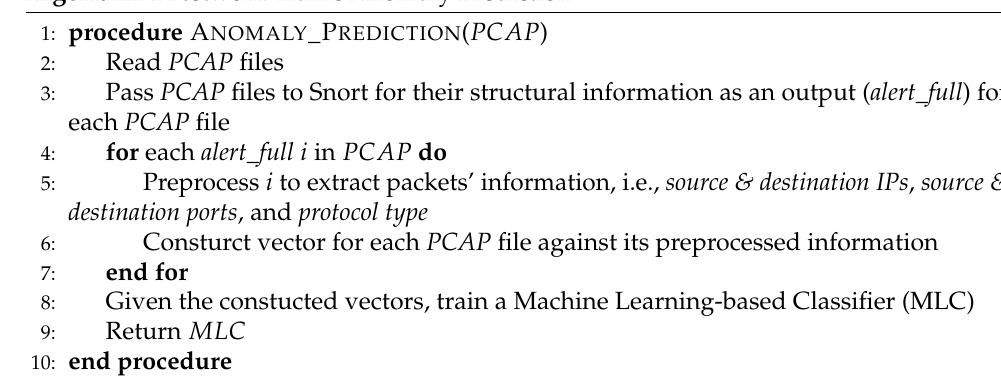
Algorithm 1 Network Traffic Anomaly